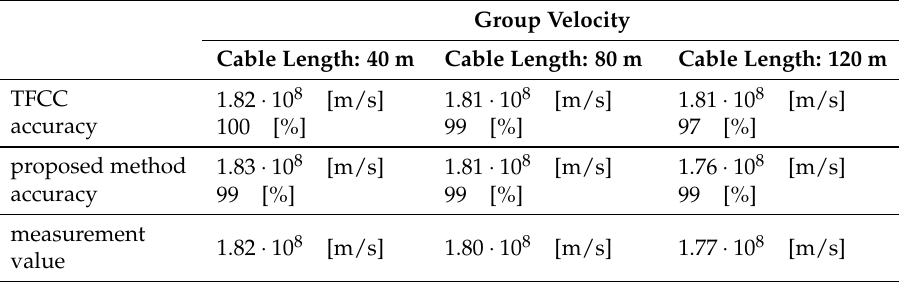
Figure 4. The results of ( a ) acquired signals, ( b ) TFCC graph. Table 1. Estimation results of group